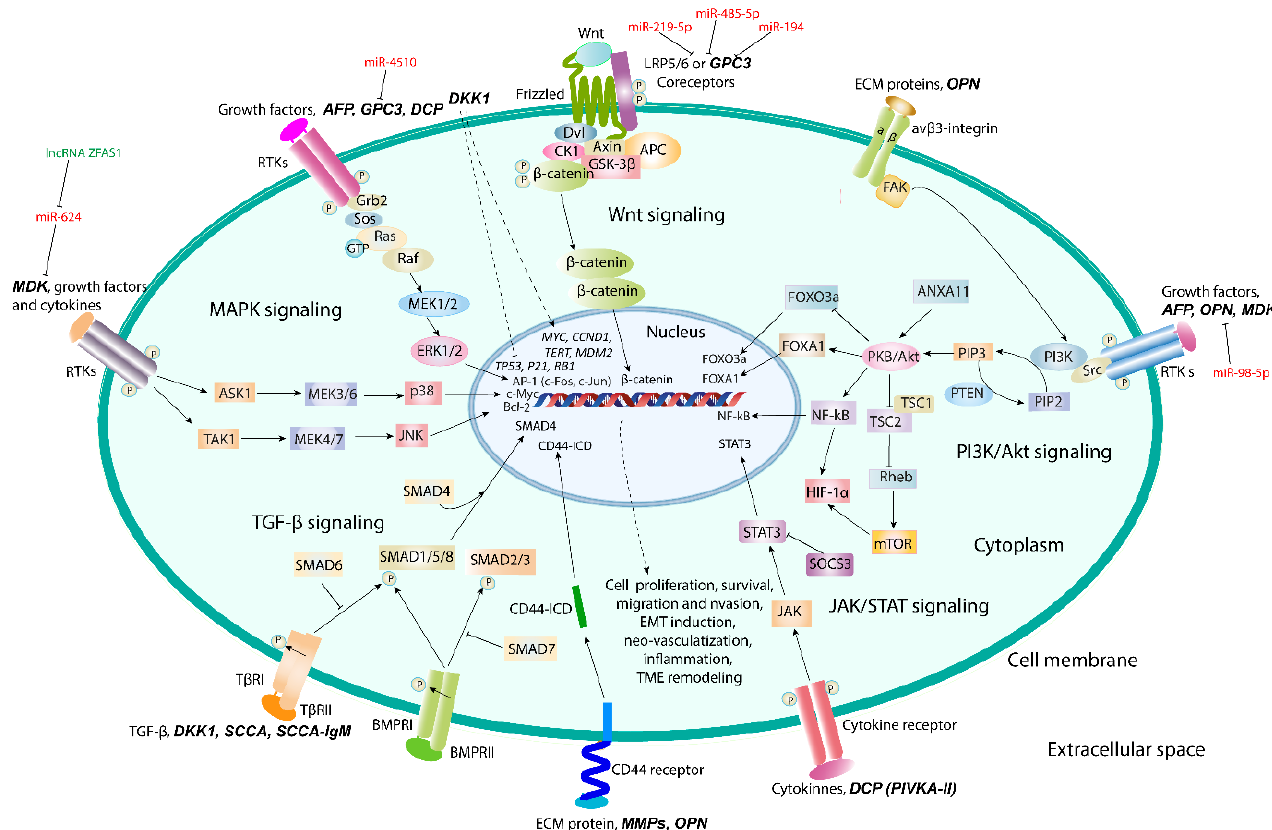
Figure 4. Cell signaling pathways involved in hepatocellular carcinoma progression. Proteomic biomarkers act through MAPK, Wnt/β-catenin, PI3K-Akt, JAK/STAT, and TGF-β/SMAD signaling pathways for cell proliferation, survival, migration and invasion, induction of epithelial-to-mesenchymal transition, angio- and vasculogenesis, inflammation, and tumor microenvironment remodeling. Regulation of a biomarker expression by non-coding RNAs and changes in gene expression signatures are shown.